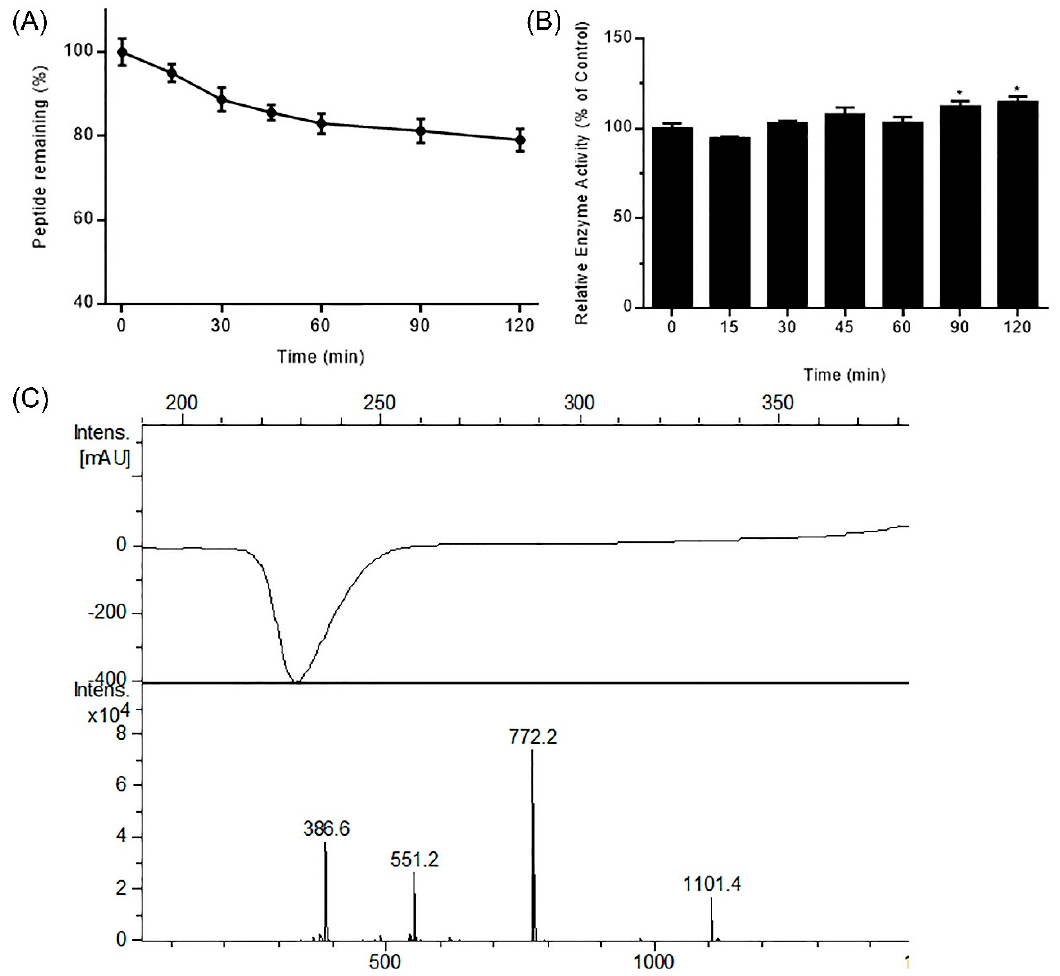
Figure 2. Stability of DhHP-6 in simulated intestinal fluid (SIF). ( A ) The remaining DhHP-6 of the degradation products collected at scheduled time was analyzed by HPLC after DhHP-6 was incubated in SIF at 37 ◦ C. ( B ) The degradation products were determined by HPLC-MS. ( C ) The relative enzyme activity of the degradation products was analyzed by the H 2 O 2 –Vitamin C double-substrate method. All results presented are means ± SD from three independent experiments. * p < 0.05 vs. control group.